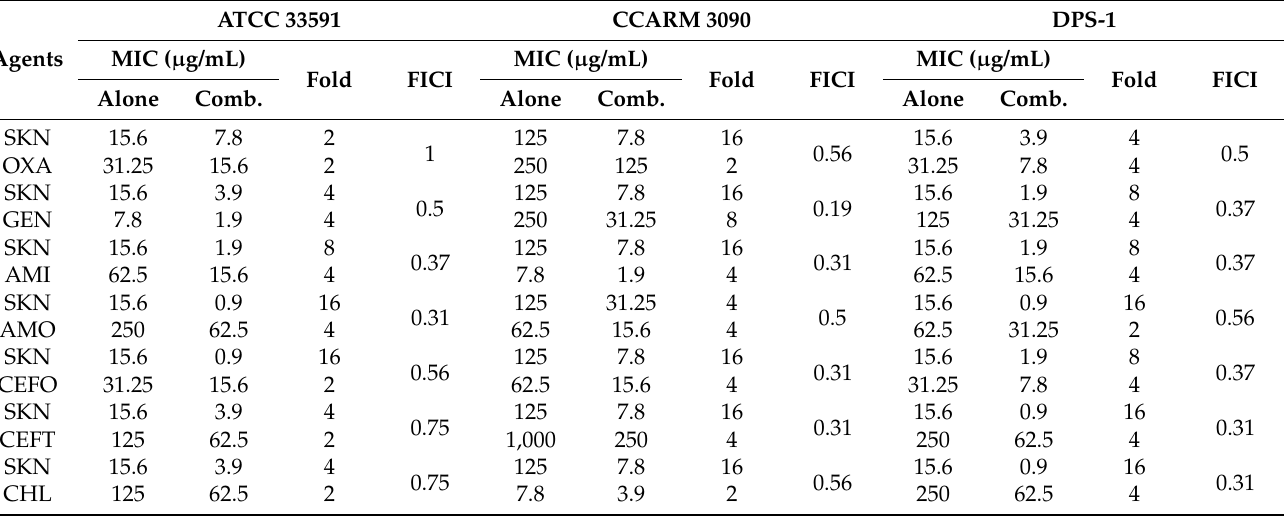
Table 1. Minimum inhibitory concentration (MIC) and fractional inhibitory concentration index (FICI) of shikonin (SKN) and seven antibiotics against MRSA ATCC 33591, CCARM 3090 and